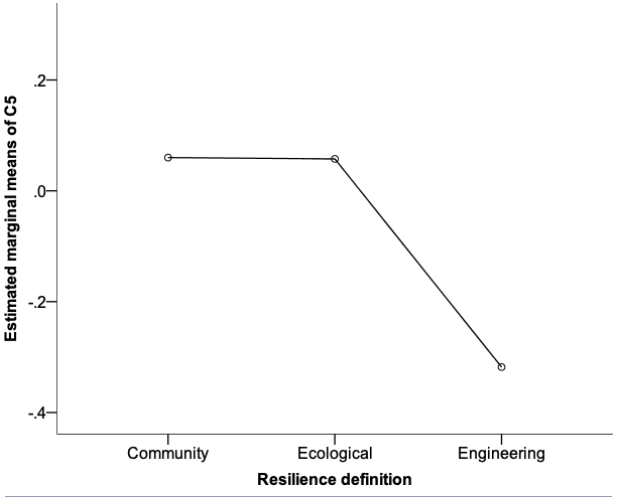
Fig. 7 . The variation in favored strategies based on participants’ choice of definitions of resilience. C2: Decentralized water governance and C5: Adaptation to floods are significantly different between groups ( p < 0.05) (see Appendix 1 for more details). The other three components (C1,C3, and C4) did not vary significantly by definition. Note: the estimated marginal mean refers to the mean response for each factor adjusted for any other variables in the